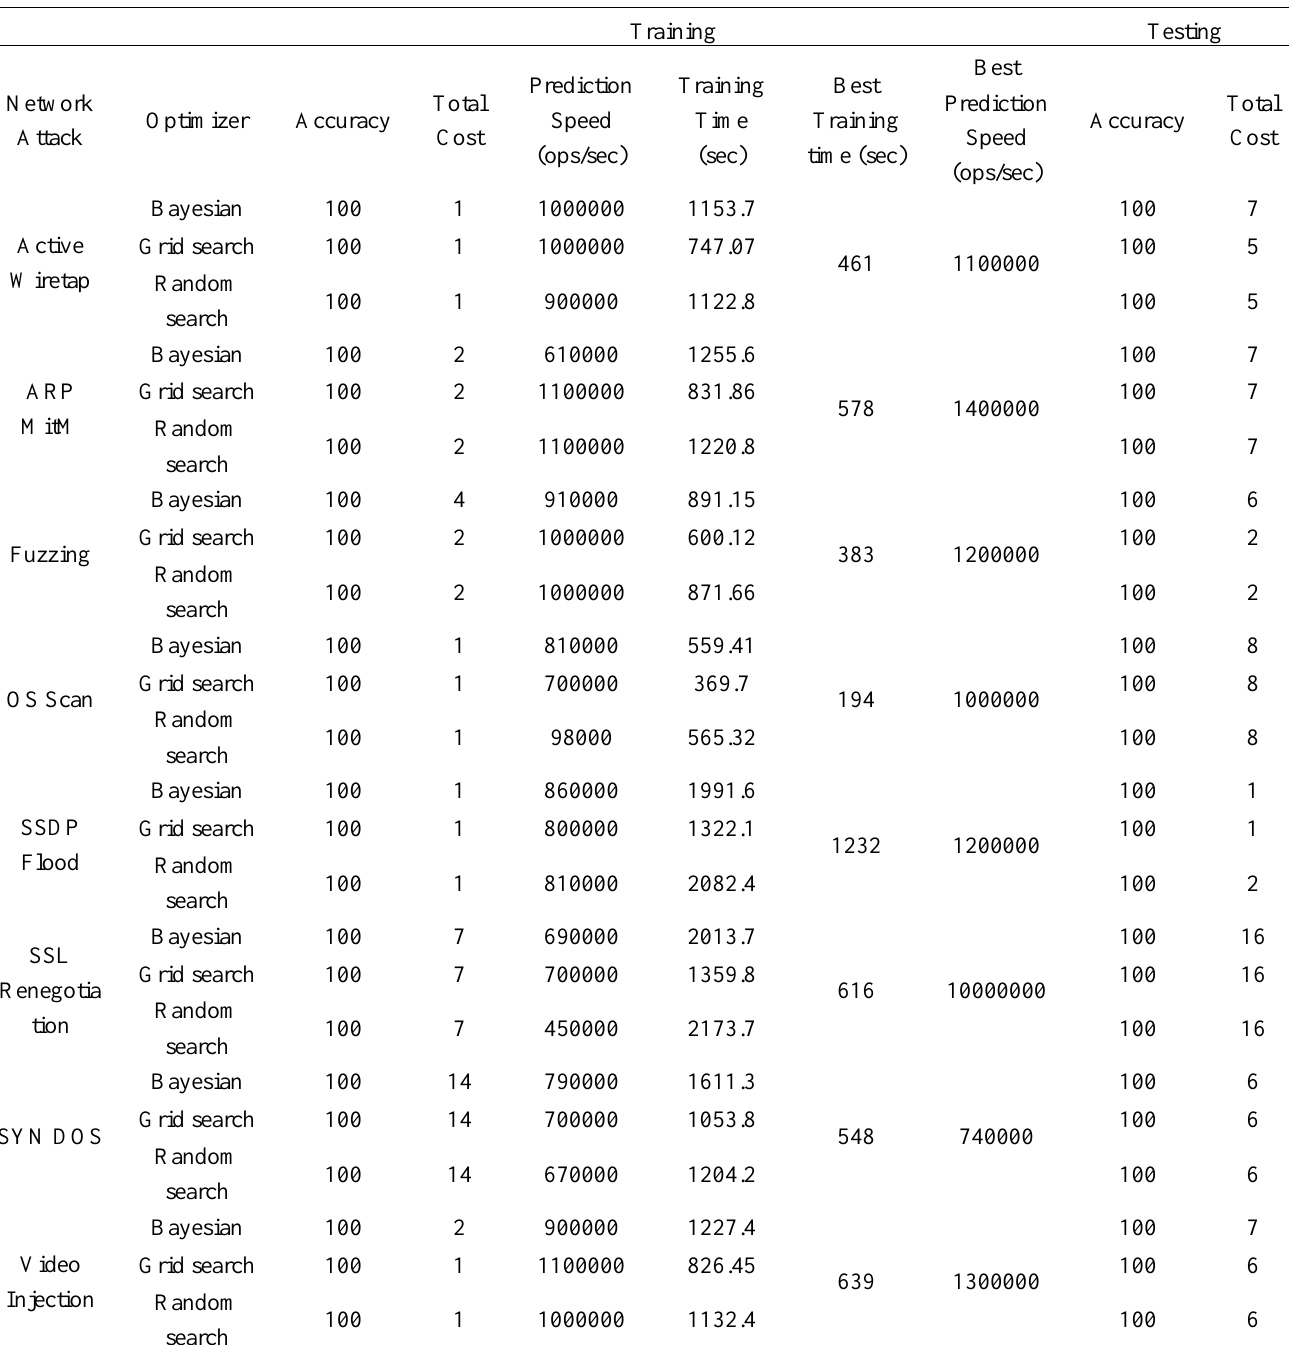
Performance evaluation of optimize tree algorithm with optimizers